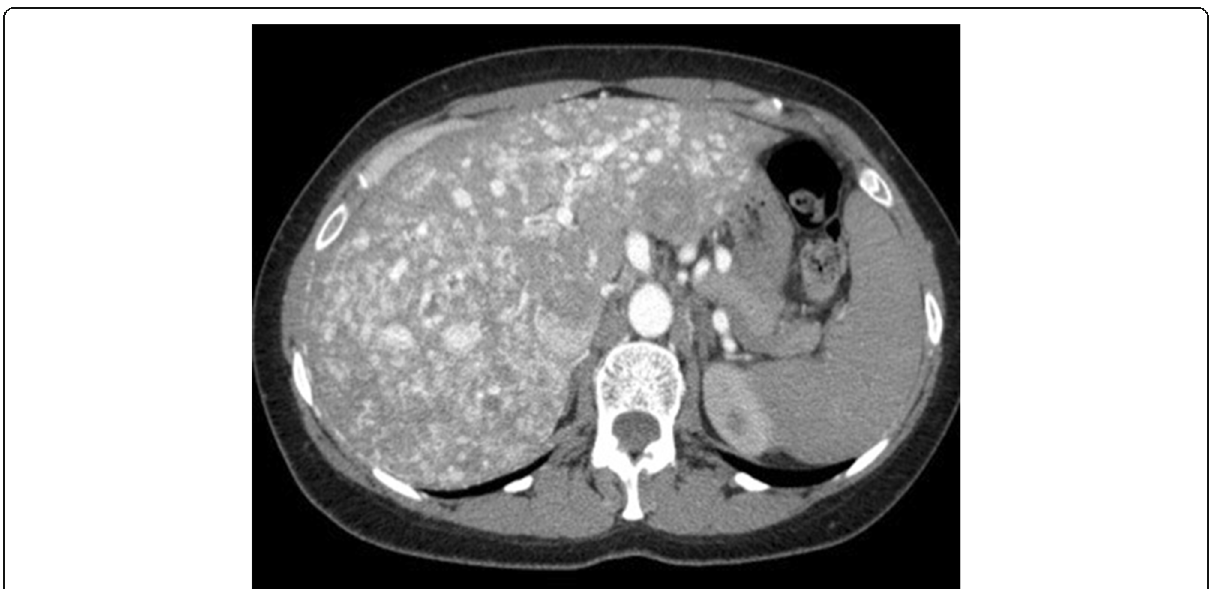
Fig. 6 Axial CT with contrast of a 45-year-old woman with HHT demonstrates innumerable enhancing arteriovenous malformations throughout the liver parenchyma. Partially visualized is hypertrophy of the celiac